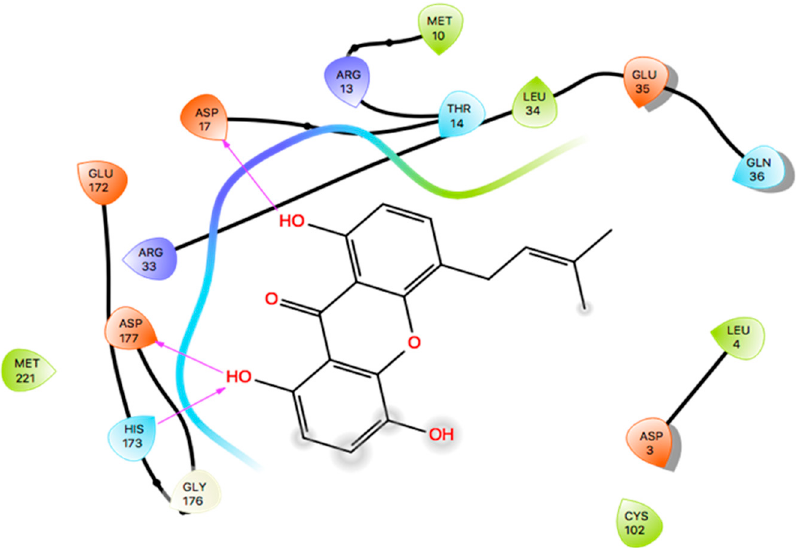
Figure 8. Two–dimensional interaction map of ZINC000095485921–ideR complex obtained after IFD. Hydrogen bonds are shown in violet lines with arrow heads.